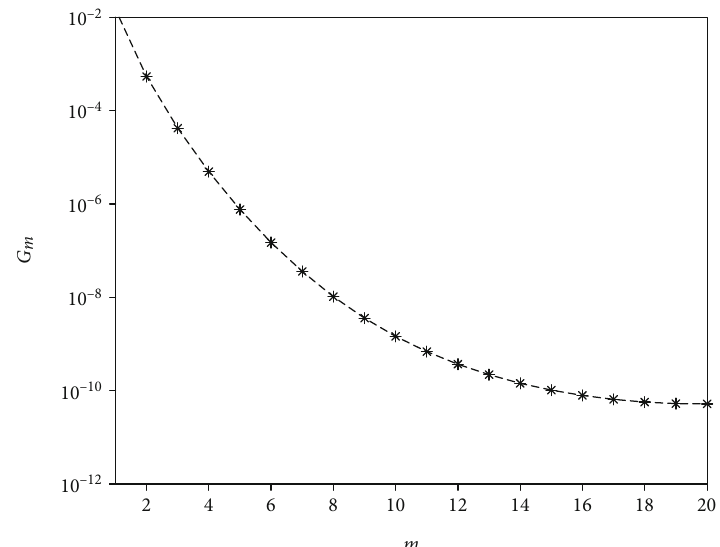
against increasing order ð m Þ of LSPM series approximation when n = 0 : 5, K = m